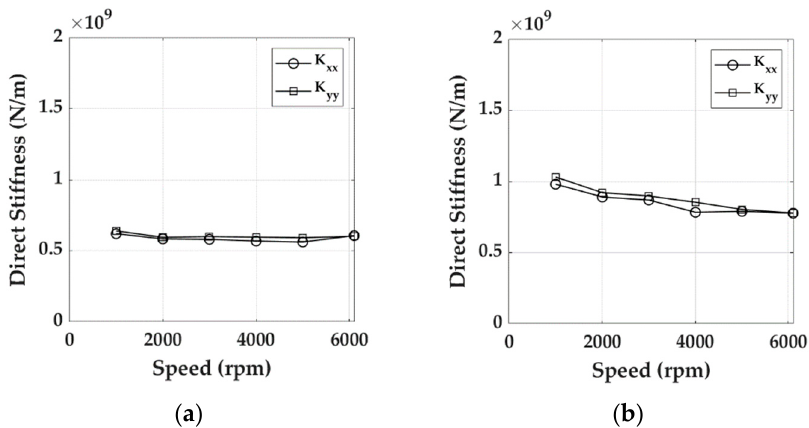
Figure 31. Flooded Ball & Socket Pivot bearing synchronous direct stiffness: ( a ) 1.0 MPa, ( b ) 1.7 MPa.